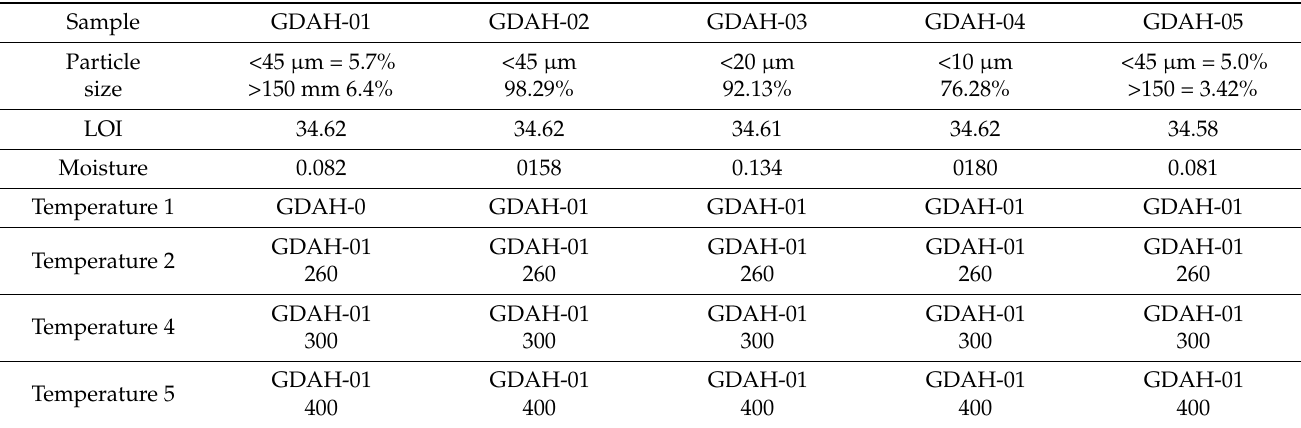
Table 6. Low-temperature aluminium hydroxide sample